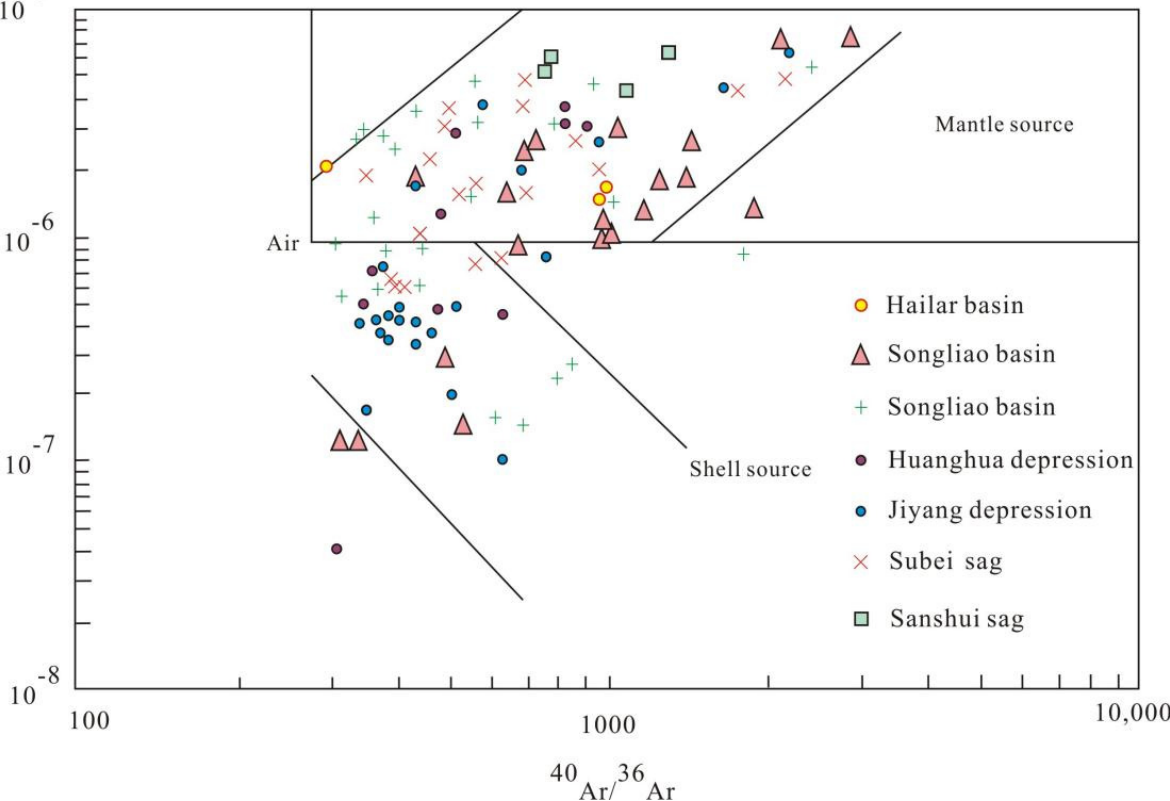
Figure 4. Diagram of 3He/4He and 40Ar/36Ar in Wuerxun depression of Hailar Basin (according to Xu Yongchang, 1996, modified).